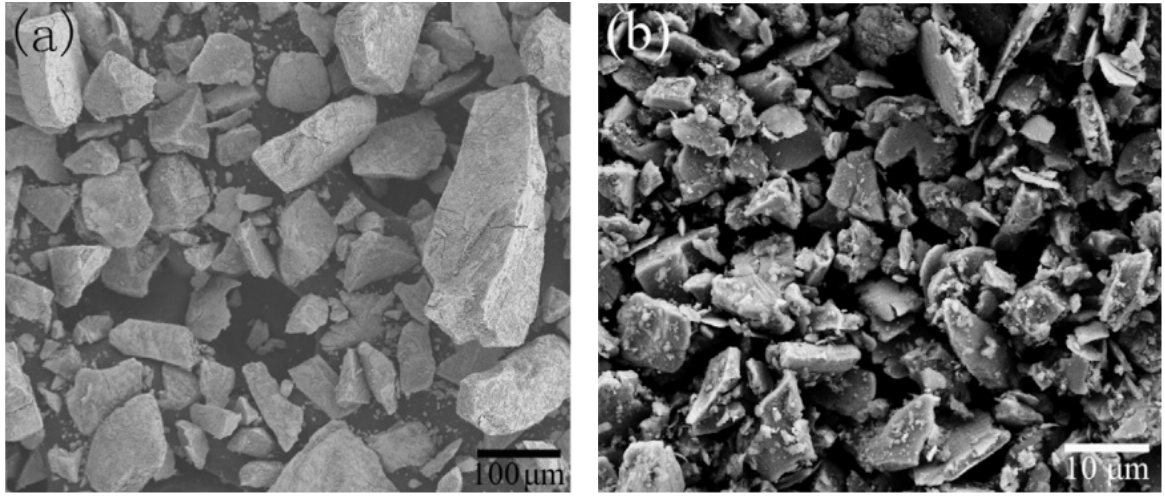
Figure 7. SEM images of H-Mg 3 La with particle sizes of ( a ) [>38] μ m and ( b ) [<12] μ m [68]. Reproduced with permission from [68], copyright 2014 Elsevie